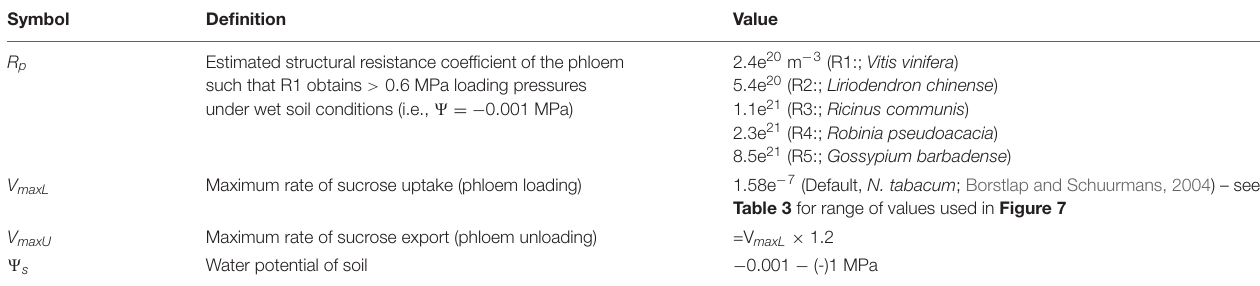
TABLE 2 | Parameters which varied during the simulations.